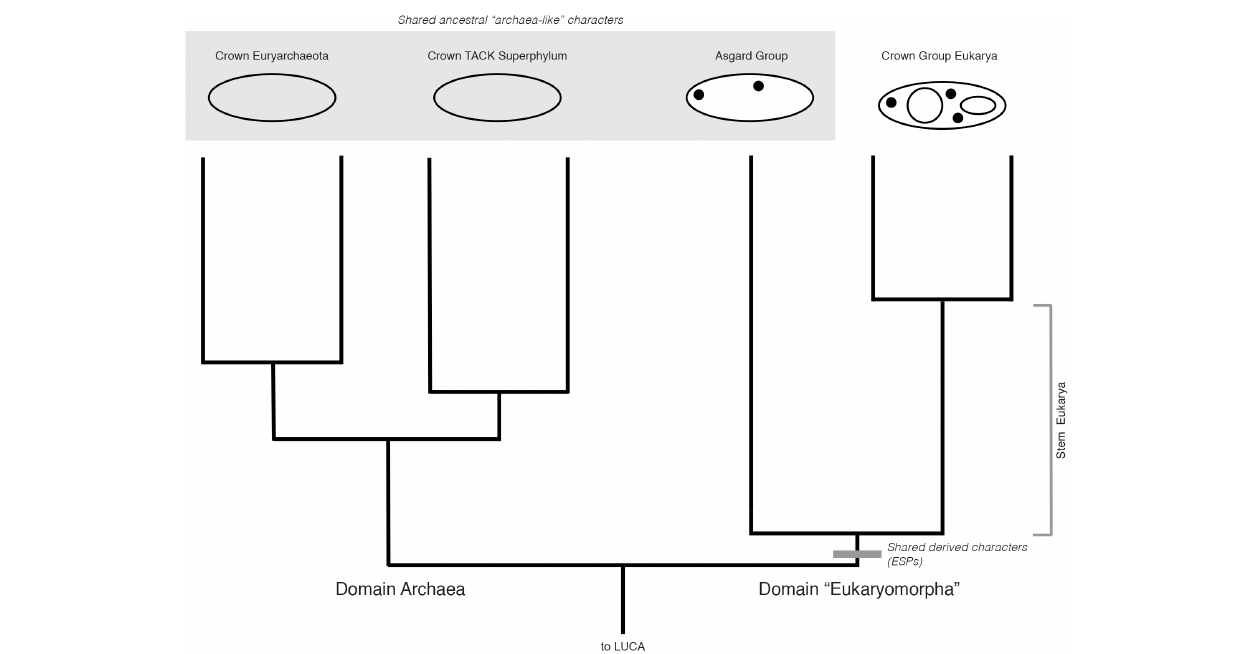
FIGURE 2 | Hypothetical rooted archaeal tree including Asgard and eukaryotes, consistent with a “3-Domain” topology. ESPs (black dots) are synapomorphies uniting Asgard and eukaryotes as a clade (gray bar). Additional archaeal groups (e.g., DPANN) are omitted for clarity. Archaeal and Asgard groups share many “archaeal-like” ancestral characters (large gray box). Archaea are depicted as rooted between Euryarchaeota and TACK, although this hypothetical 3-Domain topology is also valid under all other rootings for this group. Despite these ancestral characters, with this rooting, Asgard + Eukarya together constitute a clade of equal taxonomic rank to that of Archaea. Here, we propose the name “Eukaryomorpha,” reflecting the shared characters uniting this group and distinguishing them from the archaeal